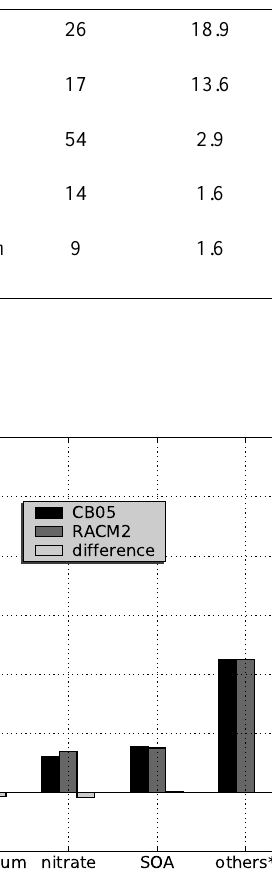
Table 4. Comparison of modeled concentrations to observations from the EMEP database (µg/m 3 ). Stations